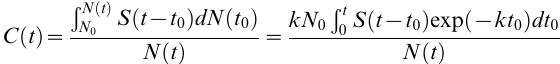
Figure S1 Binding time constant dependence of calcium signal shift: (A) Convolution of S(t), the calcium signal instantaneously triggered by soluble anti-CD3 ( N ) by the time function N(t) = Nmax(1 2 exp( 2 kt) reporting the growth of the particle- bearing cell population is shown for increasing values of the time constant k. Corresponding characteristic times (1/k) of 10; 25; 50;100; 250; 1200 s are displayed with increasingly dark grey lines. 1/k= 545 s, corresponding to our experimental situation is shown in red. (B) Signal peak shift is shown as a function of time constant. The main shift actually takes place for time constant values comprised between 0.1 and 3 min-1.